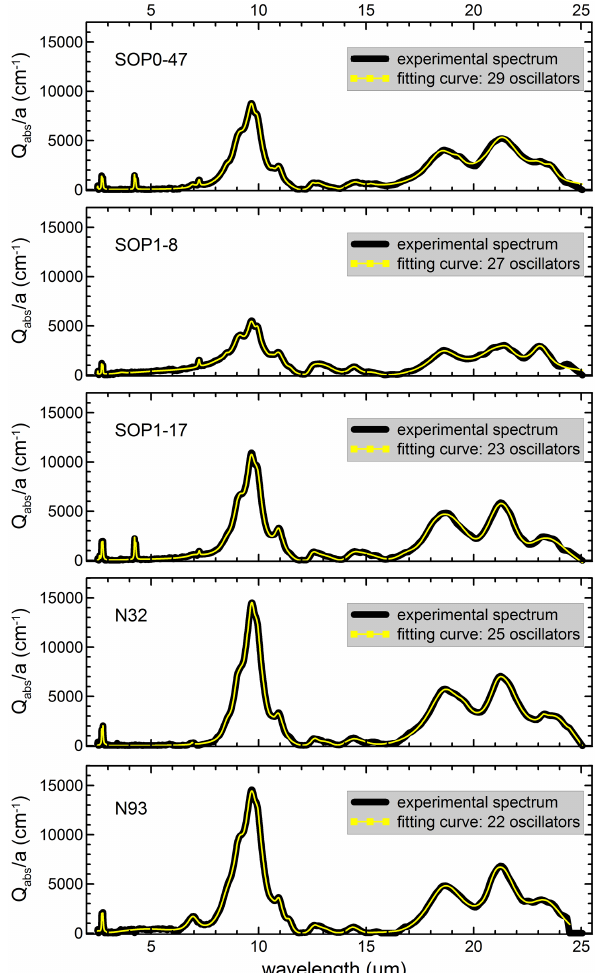
Figure 4. Comparison between the experimental Q abs (λ)/a (cm − 1 ) spectra (black curves) and the theoretical ones obtained from the non-linear fitting procedure (yellow curves). The line styles used in the plot and the number of oscillators for each fit are also indicated in the